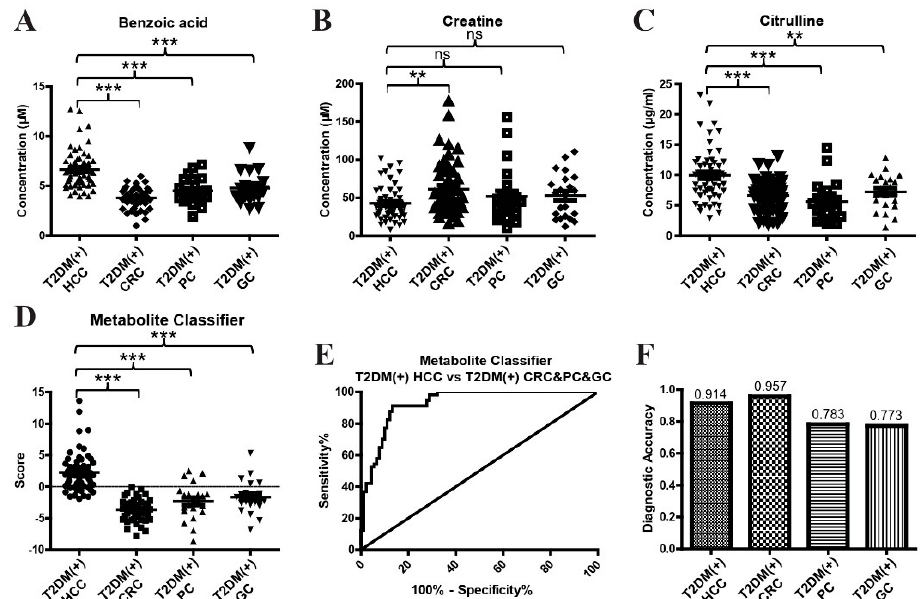
Figure 7. The specificity of the metabolite classifier in the diagnosis of T2DM(+) HCC patients. ( A ) The levels of serum benzoic acid in T2DM(+) HCC, T2DM(+) CRC, T2DM(+) PC, and T2DM(+) GC patients in the validation cohort. ( B ) The levels of serum creatine in T2DM(+) HCC, T2DM(+) CRC, T2DM(+) PC, and T2DM(+) GC patients in the validation cohort. ( C ) The levels of serum citrulline in T2DM(+) HCC, T2DM(+) CRC, T2DM(+) PC, and T2DM(+) GC patients in the validation cohort. ( D ) The scores of the metabolite classifier in T2DM(+) HCC, T2DM(+) CRC, T2DM(+) PC, and T2DM(+) GC patients in the validation cohort. ( E ) The ROC curve of the metabolite classifier including benzoic acid, creatine, and citrulline for discriminating T2DM(+) HCC patients from T2DM(+) CRC&PC&GC patients. ( F ) The diagnostic accuracy of the metabolite classifier for the diagnosis of T2DM(+) HCC, T2DM(+) CRC, T2DM(+) PC, and T2DM(+) GC patients. T2DM, type 2 diabetes mellitus; HCC, hepatocellular cancer; CRC, colorectal cancer; PC, pancreatic cancer; GC, gastric cancer; ROC, receiver operating characteristic. ** p value < 0.01; *** p value < 0.001; ns, not significant.